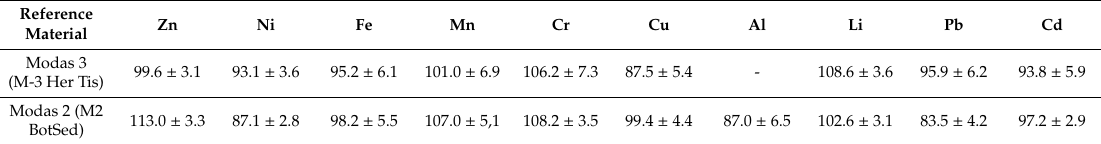
Table 3. Recovery (%) rate (mean ± SD) from reference materials MODAS-2 and MODAS-3. Reference Material Zn Ni Fe Mn Cr Cu